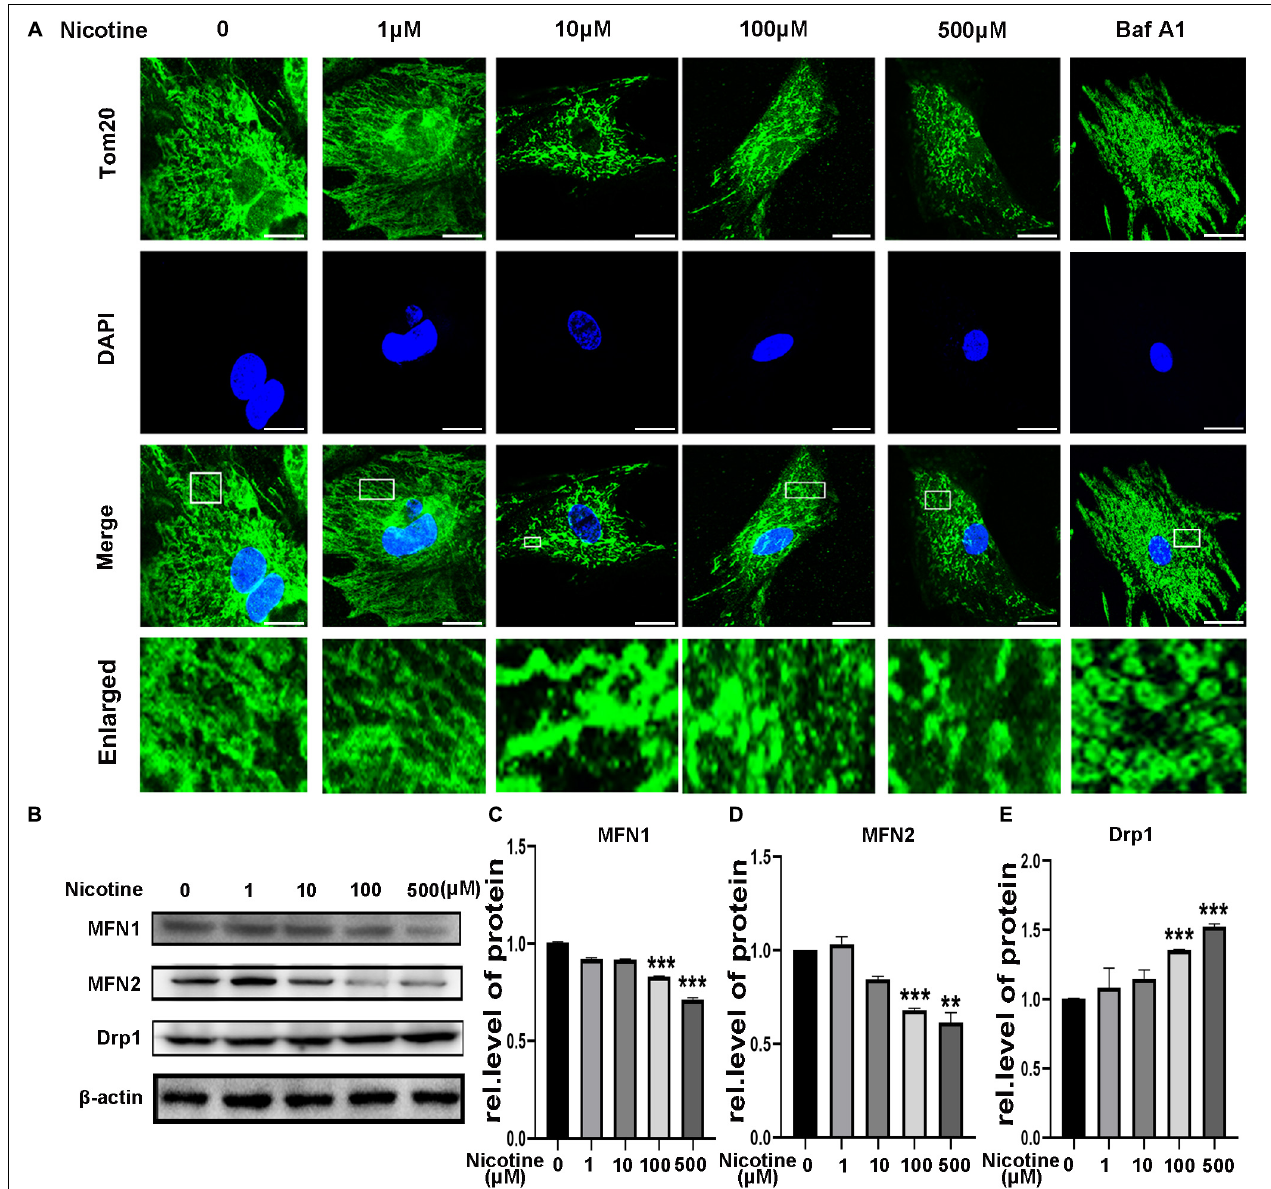
FIGURE 2 | Nicotine damaged mitochondrial morphology and altered dynamics. (A) Confocal microscopy was used to observe mitochondrial morphology of NRVMs treated with nicotine. BafA1 (100 nM) was used as positive control. Representative images of NRVMs treated with nicotine or BafA1 for 24 h. Representative of three independent experiments (Scale bar, 10 µ m). (B) Western blotting was performed to detect mitochondrial morphology and dynamics factors MFN1, MFN2, Drp1 protein levels in NRVMs after treating with nicotine. (C–E) Image J was used to quantification (*** p < 0.001; ** p < 0.01, n =